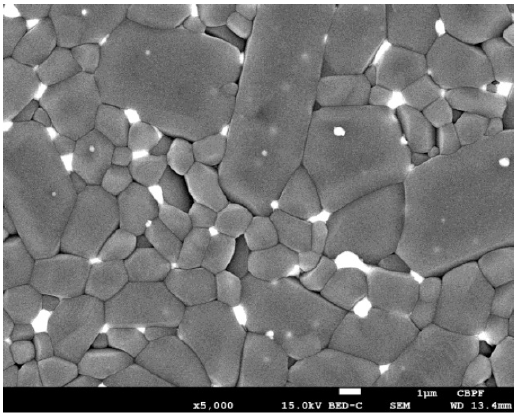
Figure 5. SEM micrograph of sintered sample of Group A, observing a smaller volumetric fraction of intergranular Ce-TZP grains (light grains) in the Al O -matrix compared to samples of Group B. 2 3 (5000X magnification).